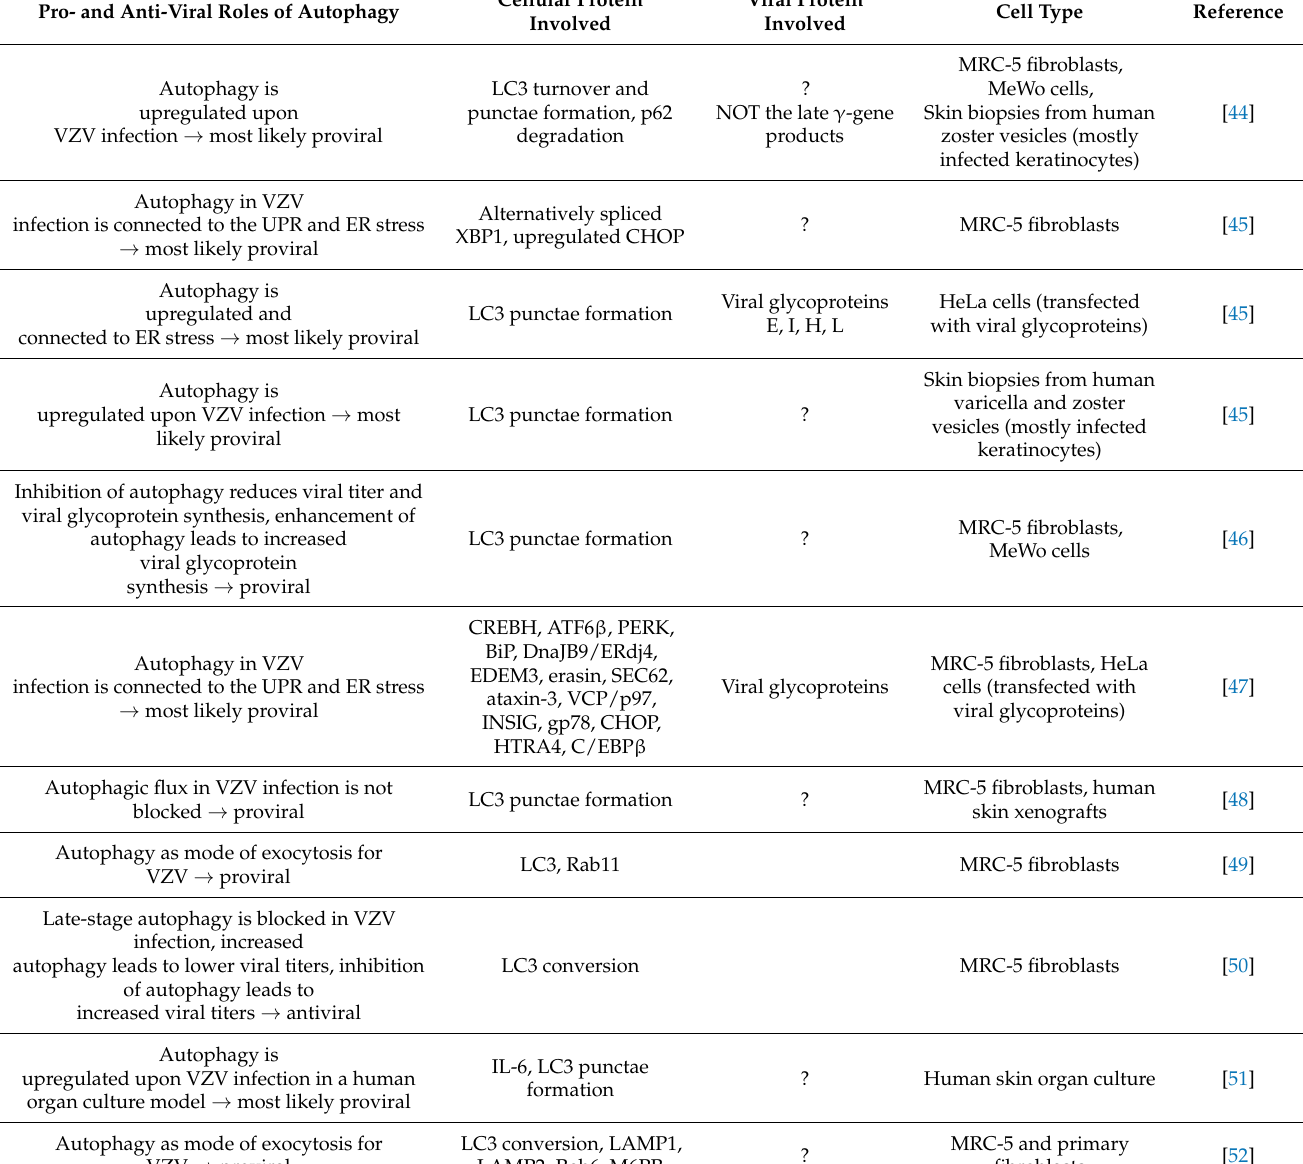
Table 1. Pro- and anti-viral roles of autophagy in VZV